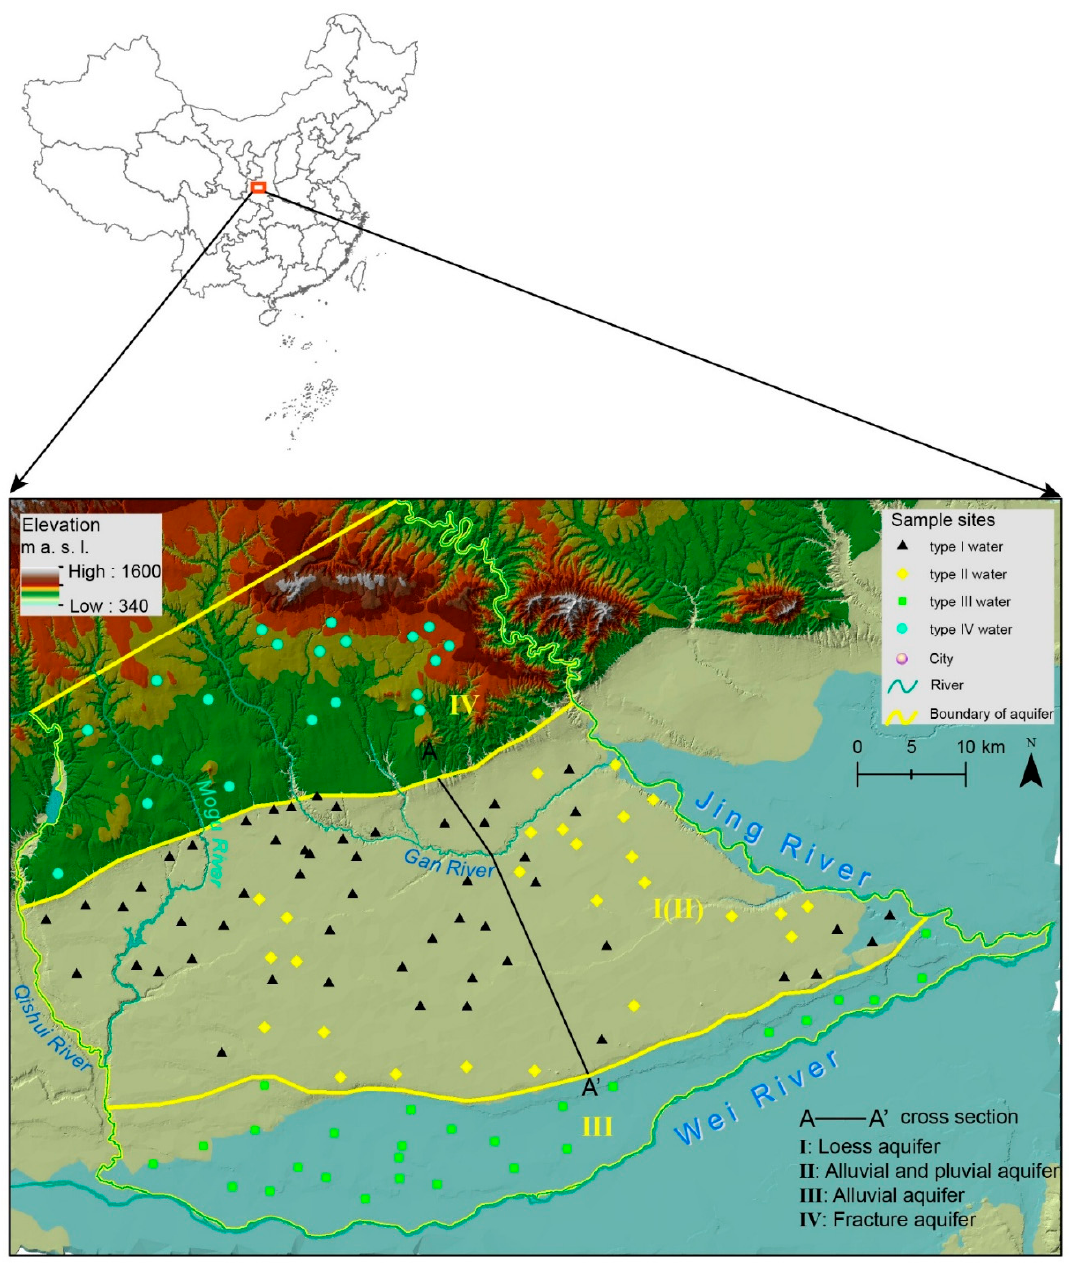
Figure 1. Study area map, showing the terrain relief, rivers, and sample sites.